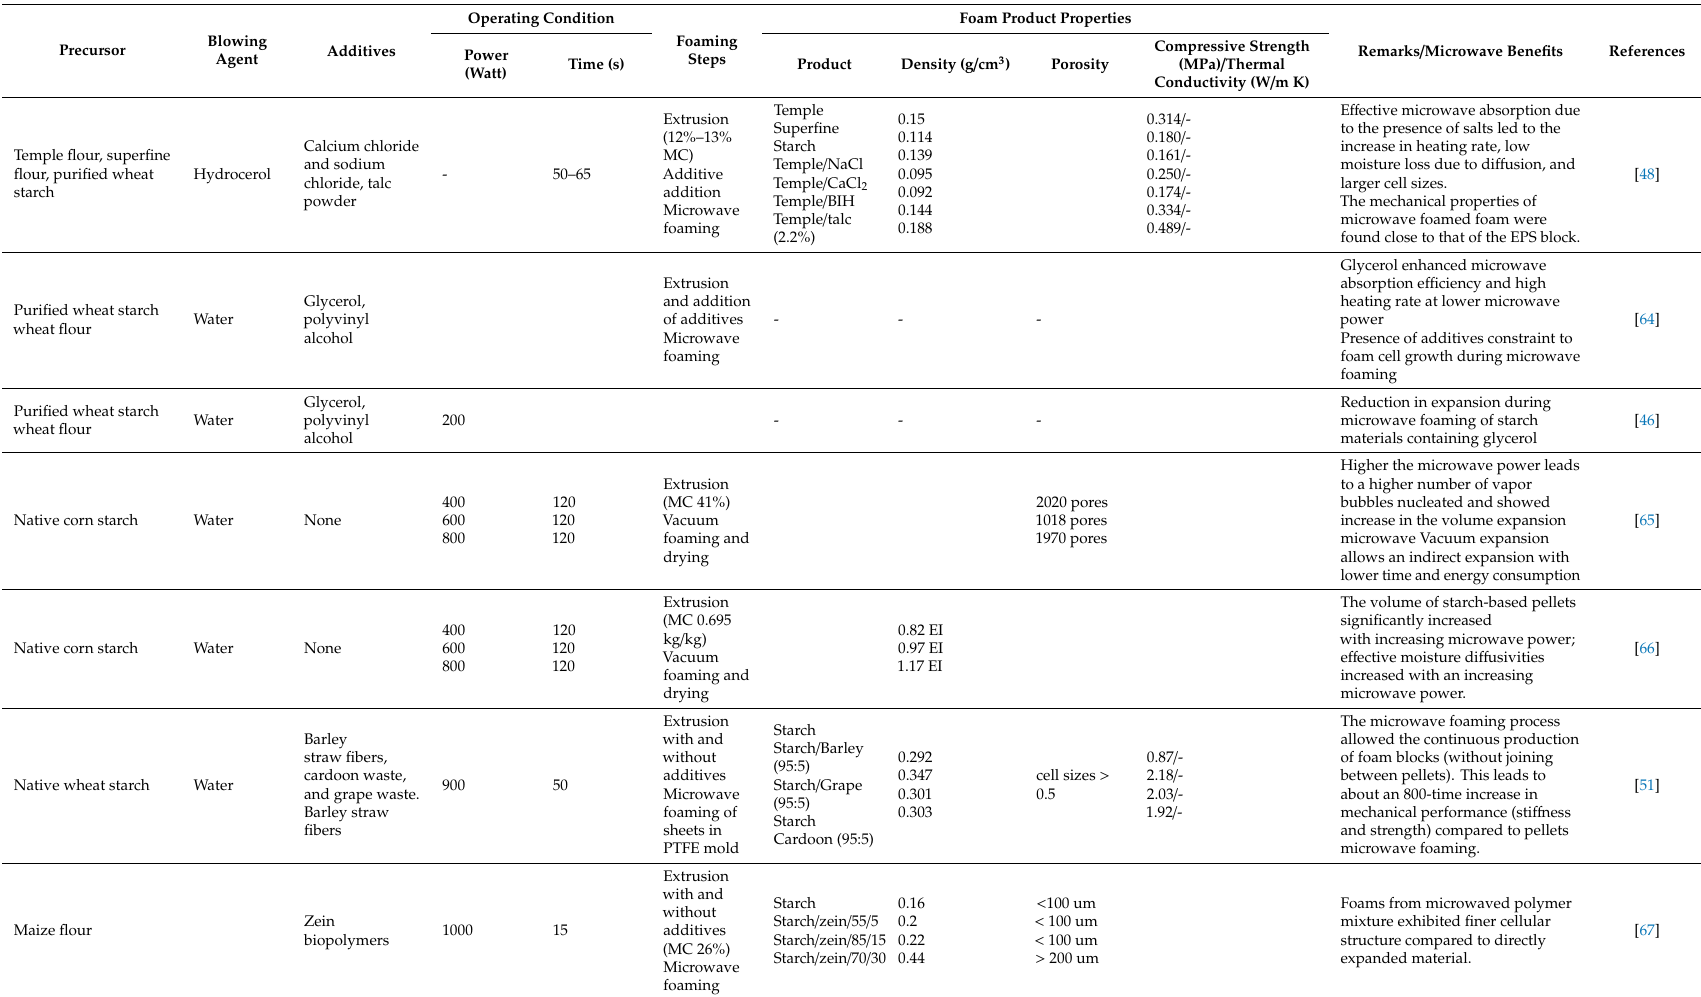
Table 2. Summary of microwave foaming process and characteristics of foamed